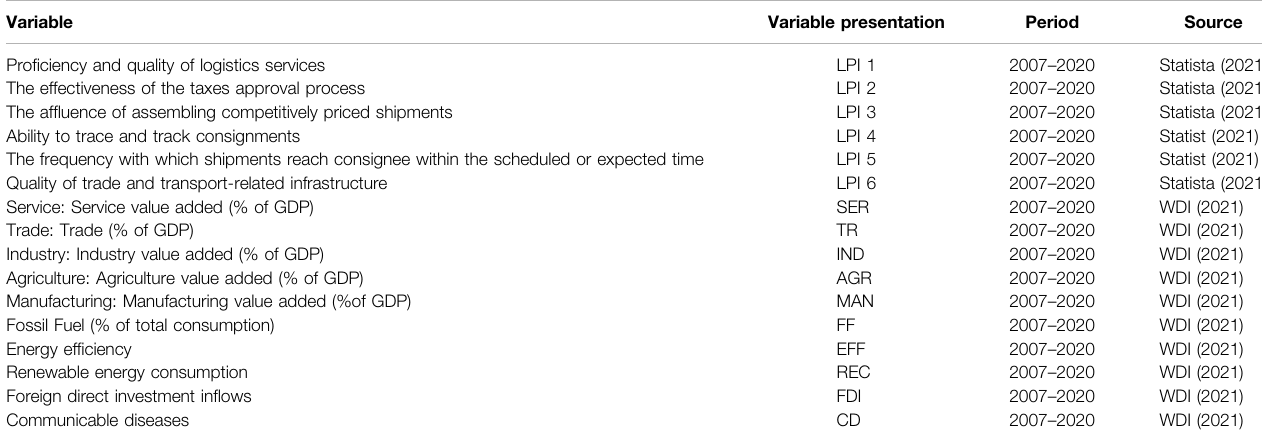
TABLE 1 | Data sources.